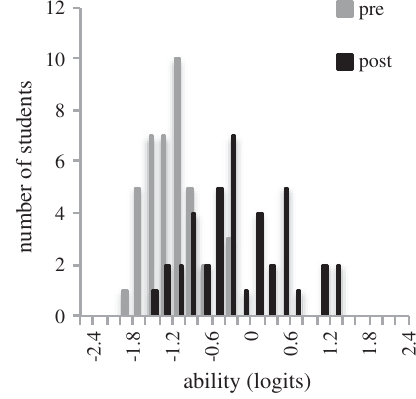
FIG. 27. The pre- and postability histograms for class 13. FIG. 30. The pre- and postability histograms for class 16.